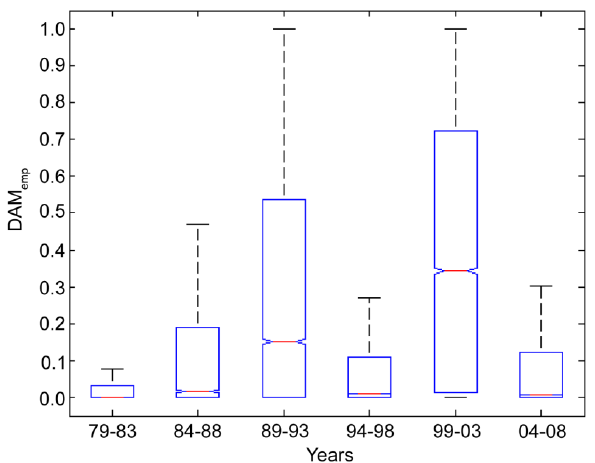
Figure 3. Boxplots of proportions of storm-damaged timber ( DAM emp ) in six five-year periods. Boxplot style: red lines indicate medians; boxes indicate interquartile ranges; whiskers indicate 1.5-times interquartile ranges.